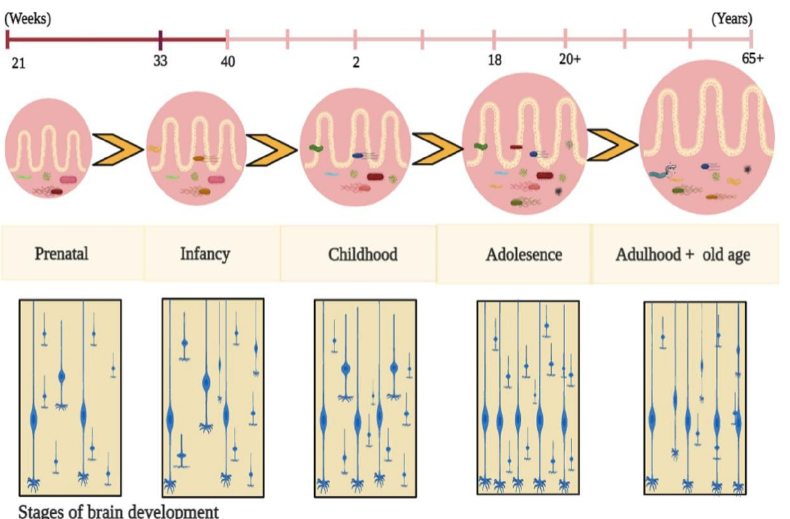
Figure 1. Evolution of the gut microbiota along with synaptogenesis throughout the lifespan. After birth, infant gut microbiota are established, and they are exposed to multiple environmental factors which influence the intestinal microbiota composition, thereby controlling physiological growth, brain development, and behaviours via gut metabolites.